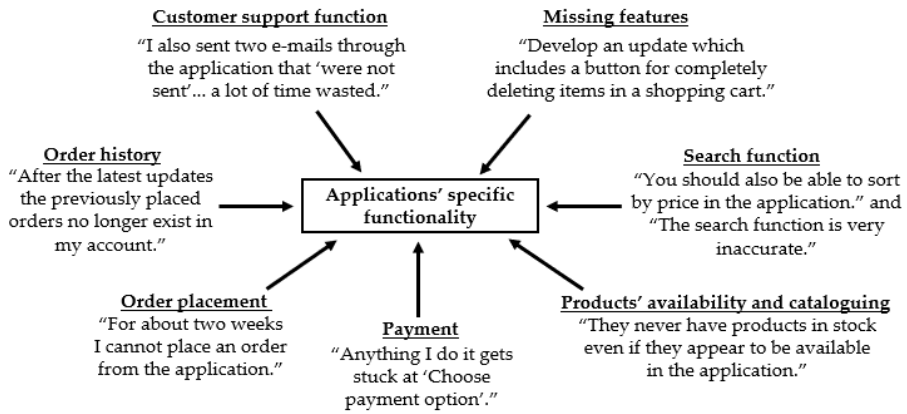
Figure 4. Examples of review comments focusing on specific functionality challenges. Source: elaborated by the authors.